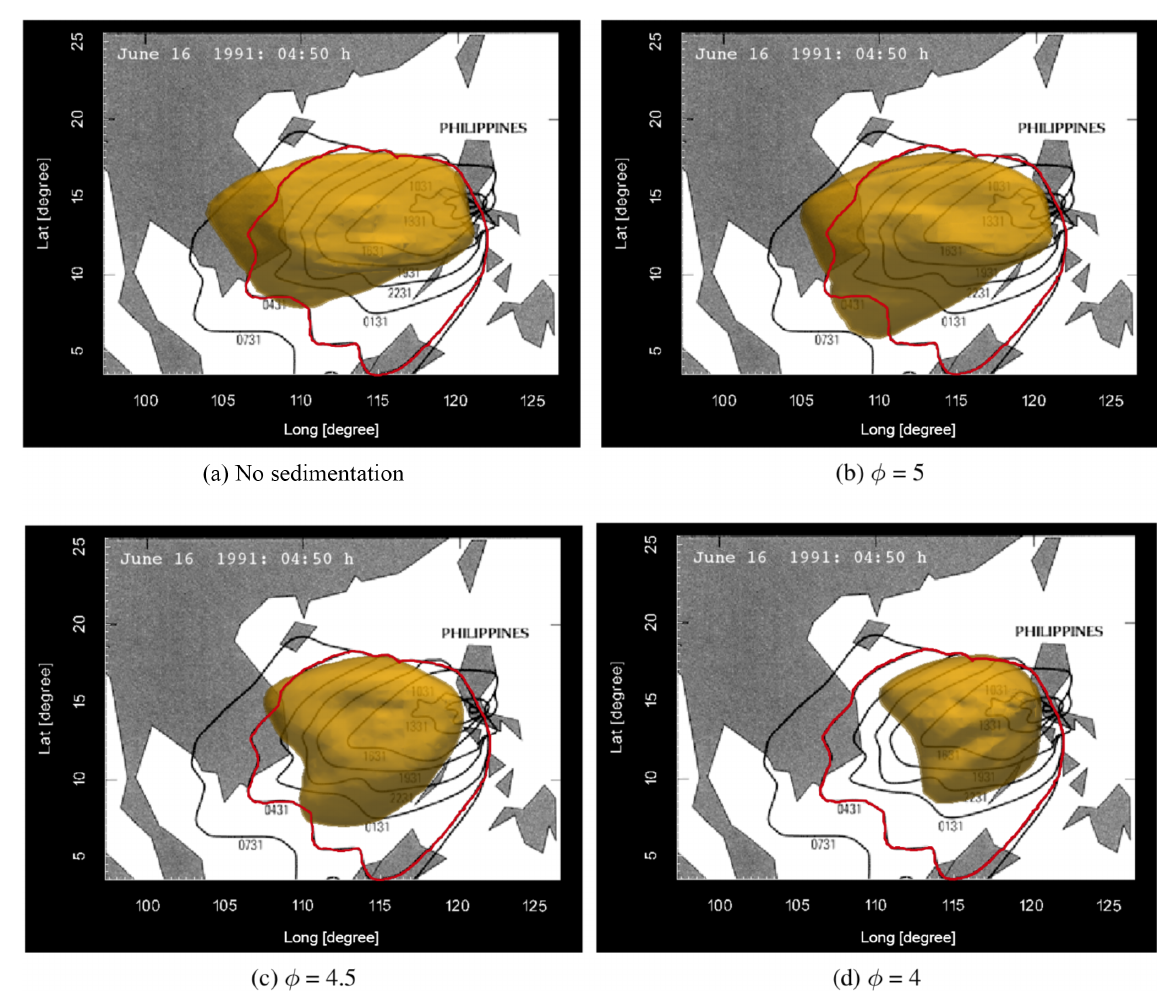
Figure 7. Advected ash cloud on 16 June 04:30 for particle sizes of 4, 4.5 and 5 φ and for a simulation without the settling of particles. In the background, the outer edge of the observed ash cloud is displayed in 3h intervals (observed contours from Lynch and Stephens, 1996). The outer edge of the simulated ash cloud was defined as the isosurface with an ash concentration of 0.05kgm − 3 , producing the closest fit to the observed data. Note that the observational contour that corresponds to our model time (16 June 04:30) is marked in